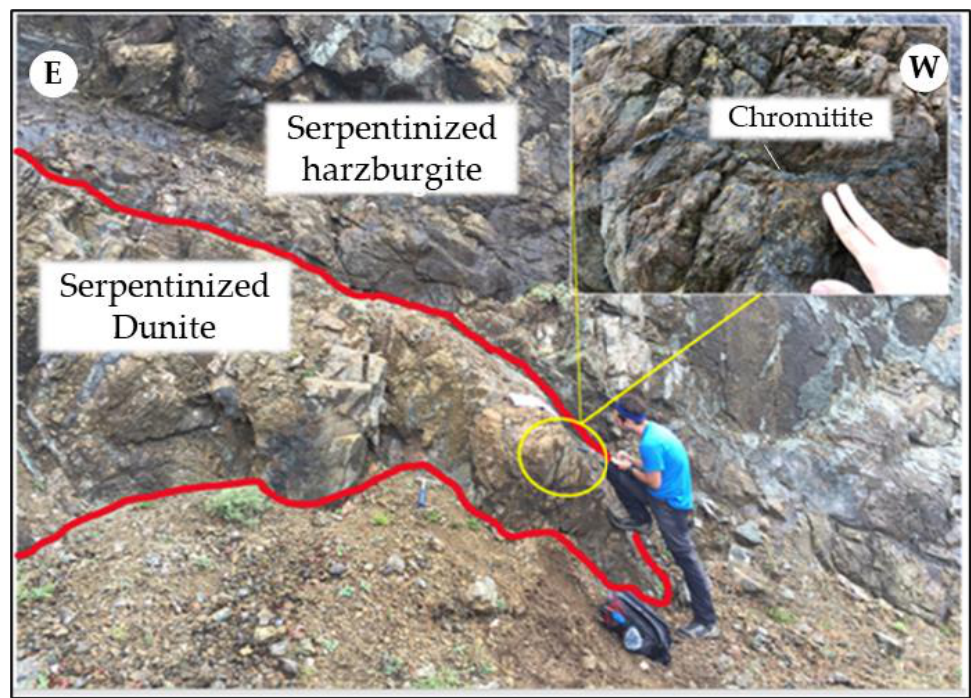
Figure 3. Chromitite pods in serpentinized dunite, hosted by partially serpentinized harzburgite at Kymasi.